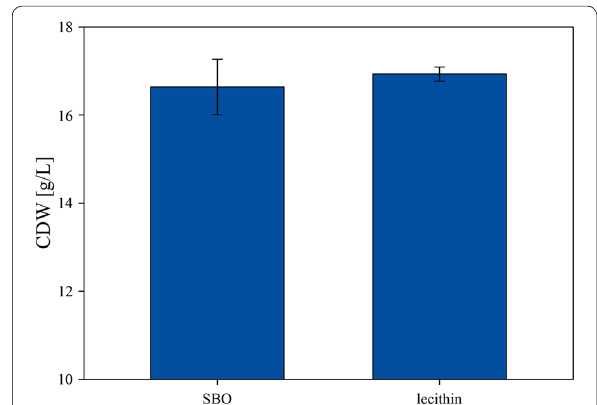
Fig. 6 Six experiments were performed either with crude SBO or extracted lecithin as media supplement. The plot shows the variance between those experiments concerning biomass